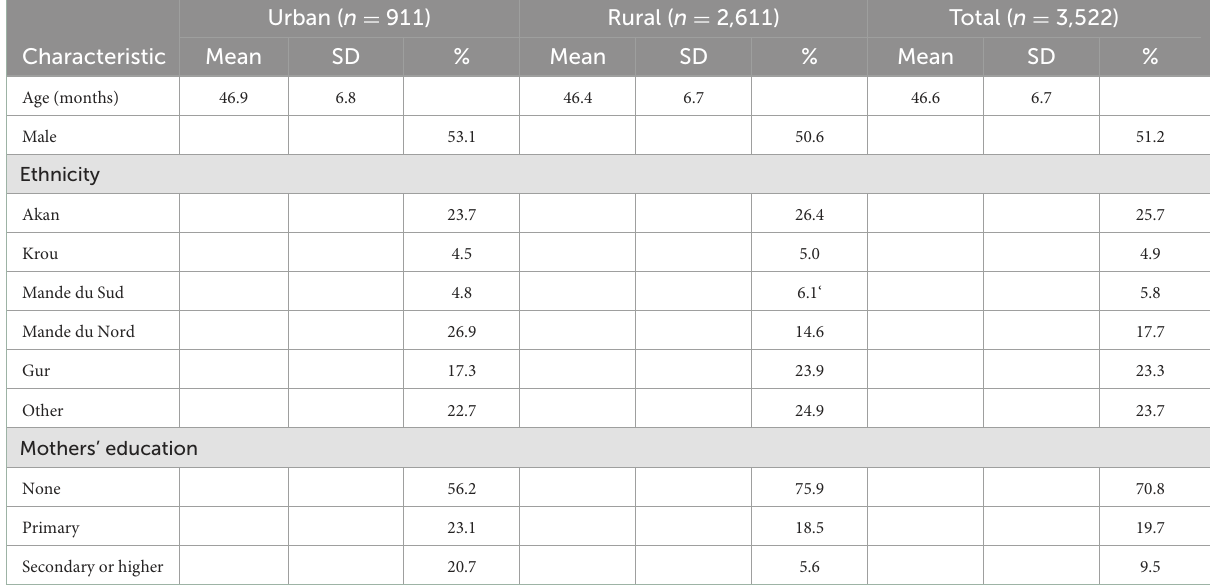
TABLE 1 Demographic characteristics of the samples of urban and rural 36- to 59-month-old children in Cote